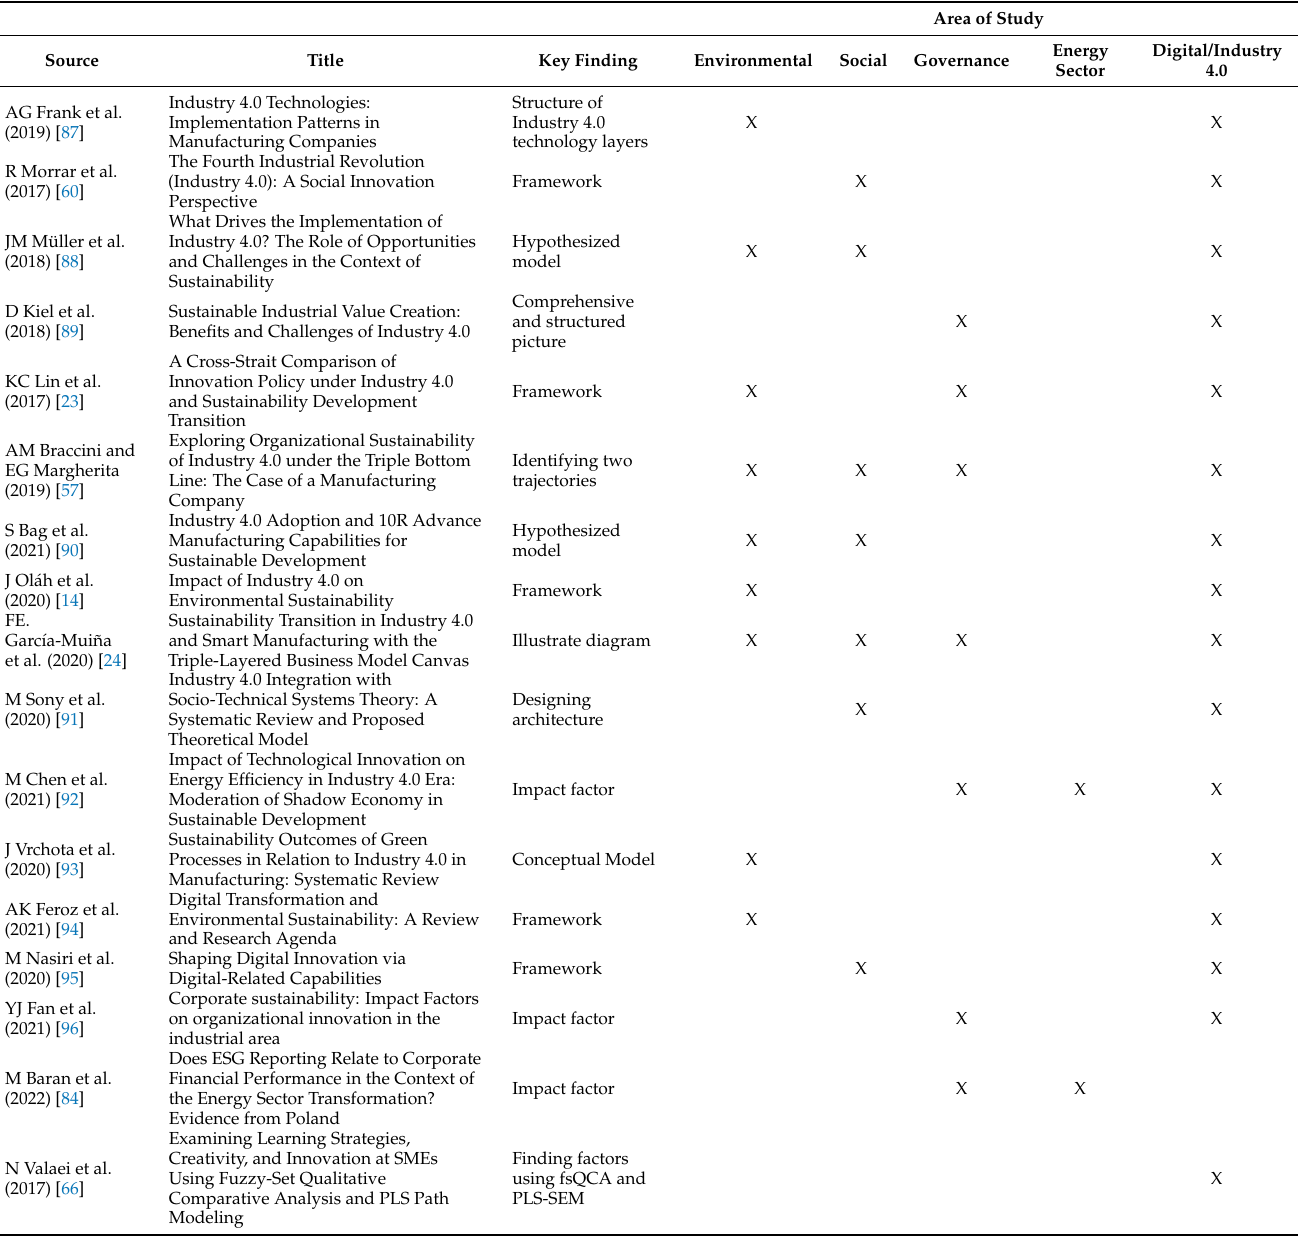
Table A1. Summary of the literature